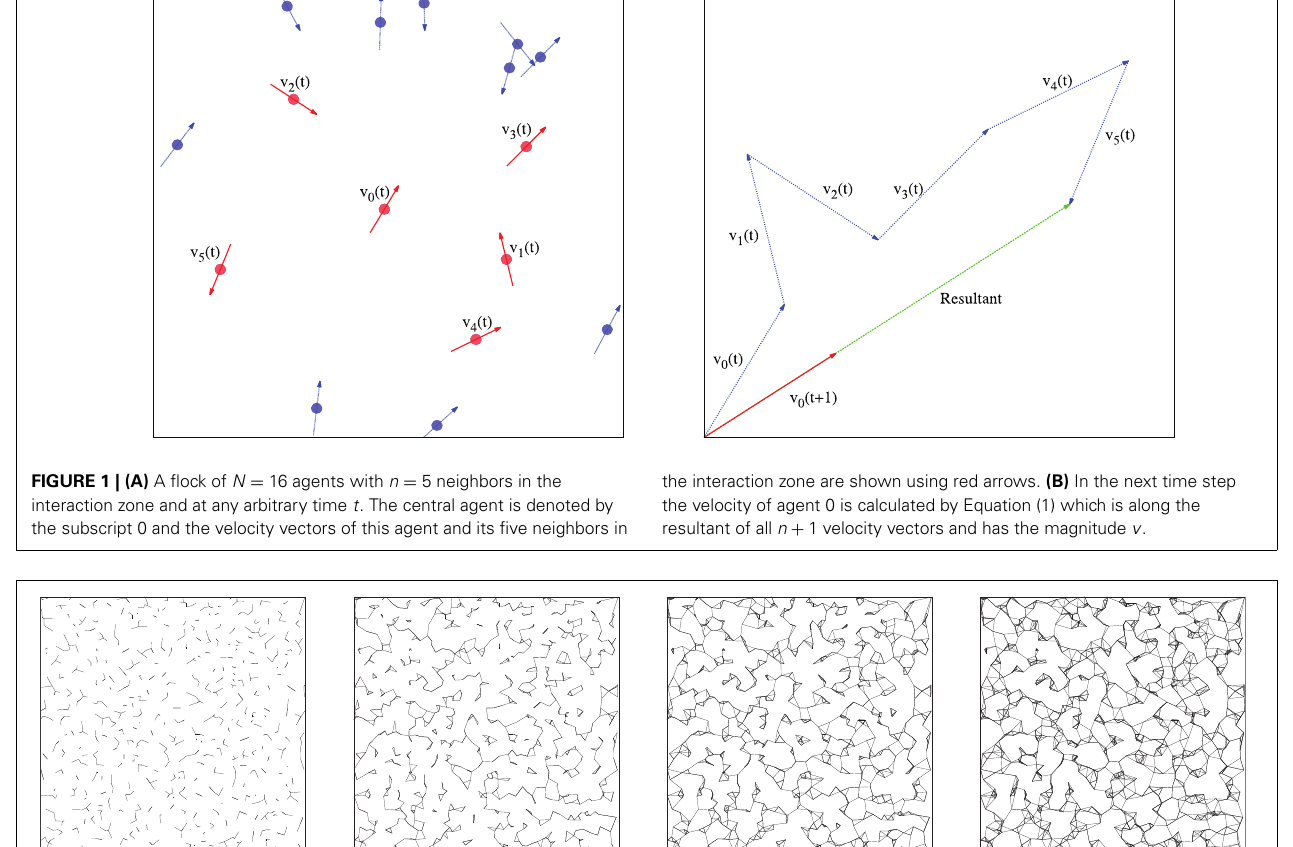
FIGURE 2 | The undirected RGG with N = 1000 nodes distributed randomly within a square box with a free boundary condition. Each node is linked to its n nearest neighbors; n = 1, 2, 3, and 4 increasing from left to